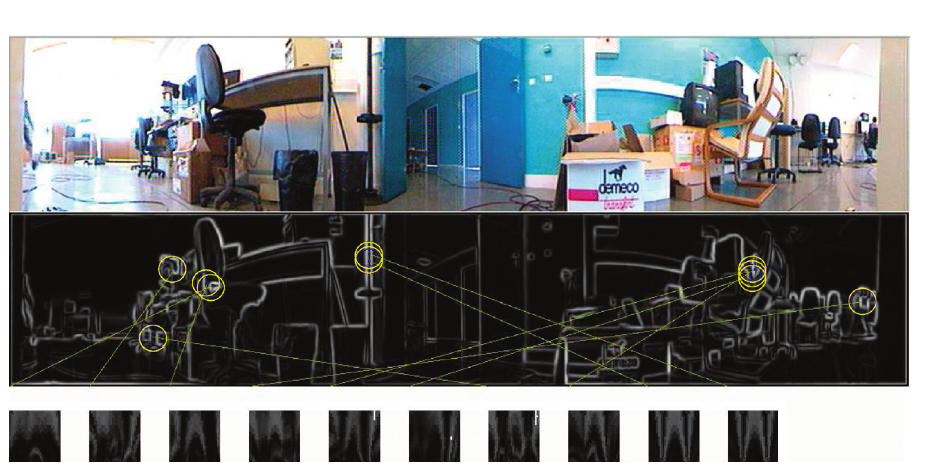
Figure 4. Results taken at different stages of the visual processing. Top , the panoramic image taken by the robot. Middle , the corresponding gradient picture. Circles represent local area centered on landmark, from which small images are extracted. Bottom , small images after the log-polar transform, the four neurons coding for the corresponding landmarks (four interpretations) and the